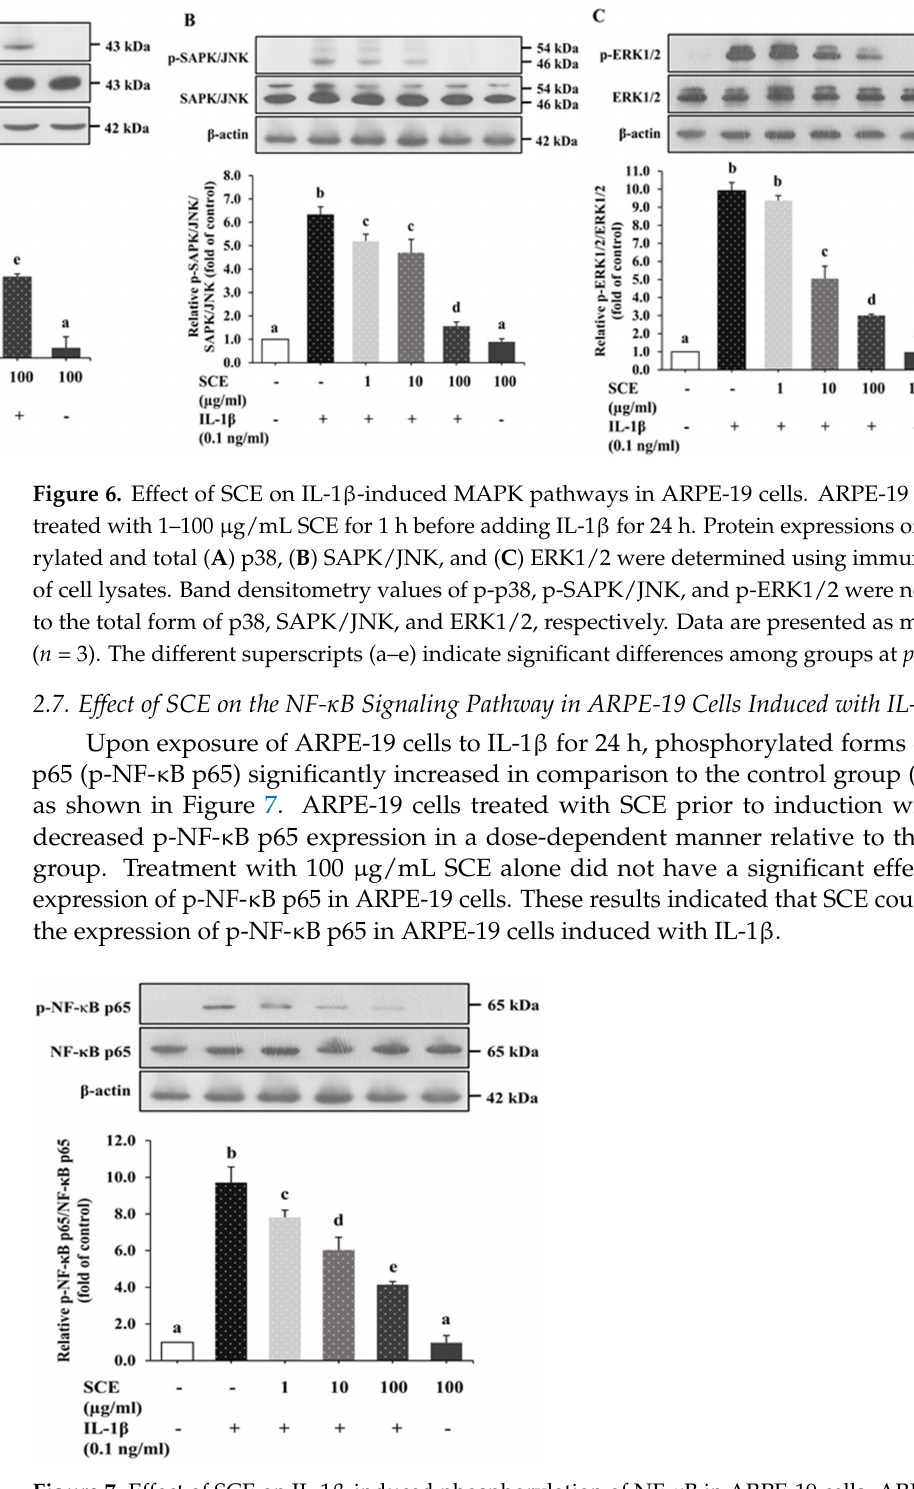
Figure 7. Effect of SCE on IL-1 β -induced phosphorylation of NF- κ B in ARPE-19 cells. ARPE-19 cells were treated with 1–100 µ g/mL SCE in 0.5% DMSO for 1 h before adding IL-1 β for 24 h. Protein expression of phosphorylated NF- κ B p65 and total NF- κ B p65 was determined using immunoblotting. Equal loading of protein in each well was normalized to the total form of NF- κ B p65. Data are presented as mean ± SD ( n = 3). The different superscripts (a–e) indicate significant differences among groups at p <